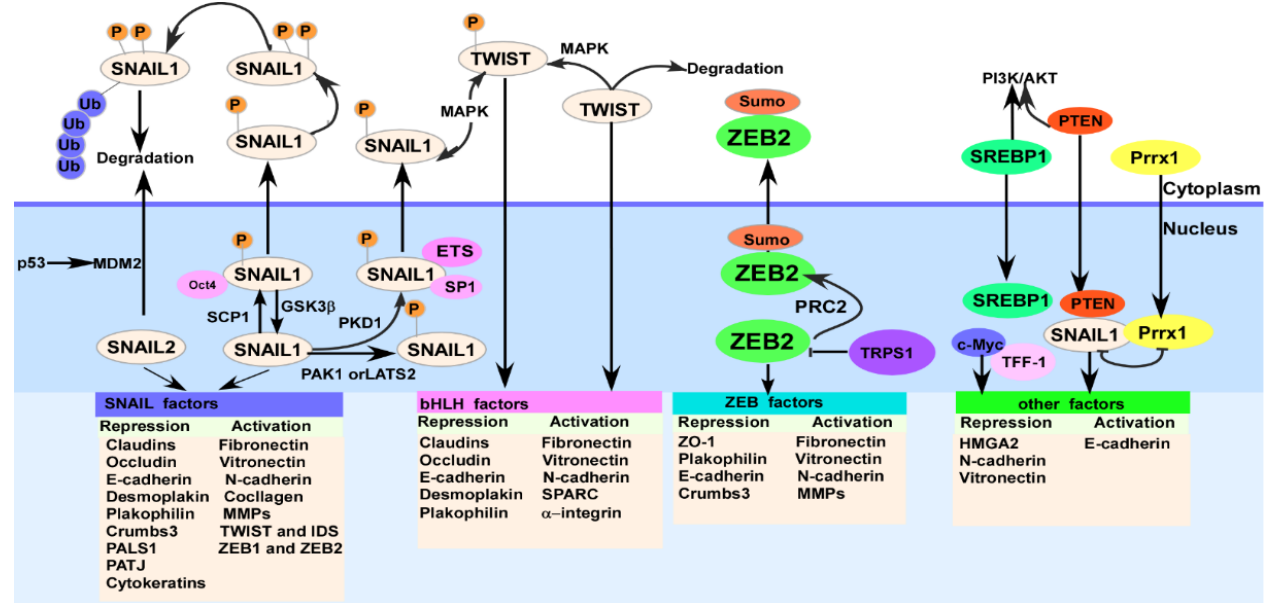
Figure 4. Multiple transcription factors regulate cellular EMT process. These transcription factors include Snail1/2, Twist, and ZEB1/2, whose activation speeds up cellular EMT, while other transcription factors, such as SREBP1, Prrx1, and C-MYC, slow down cellular EMT. Notably, certain interactive and feedback regulatory loops also exist between different transcription factors.